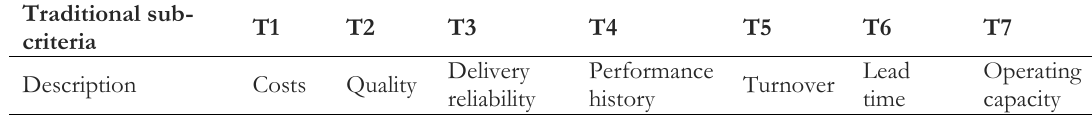
Table 4. Keys traditional sub-criteria effective on the evaluation of suppliers.